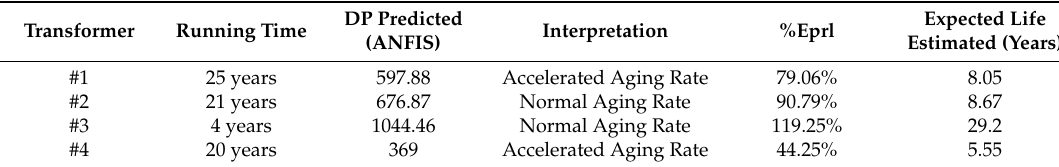
Table 13. Expected life